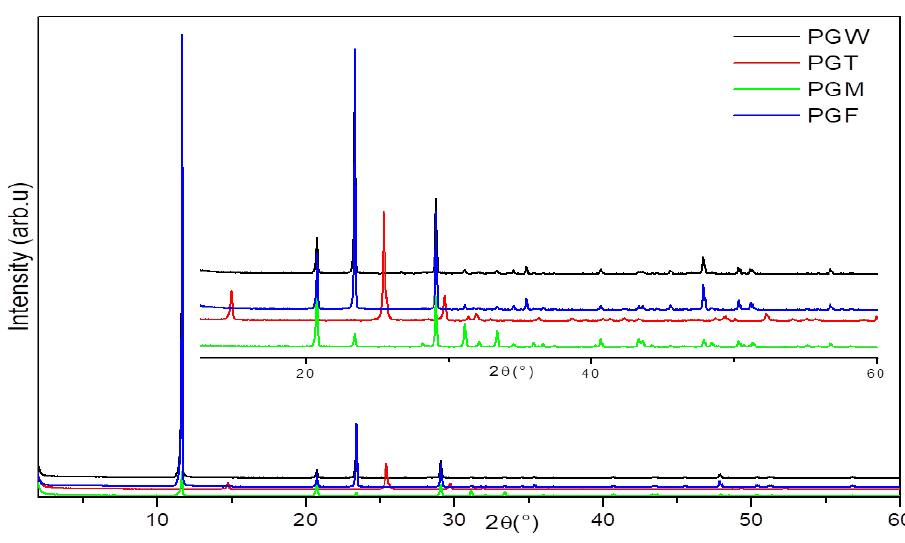
Figure 2. X-ray diffractograms of the PGF, PGW, PGT and PGM samples.